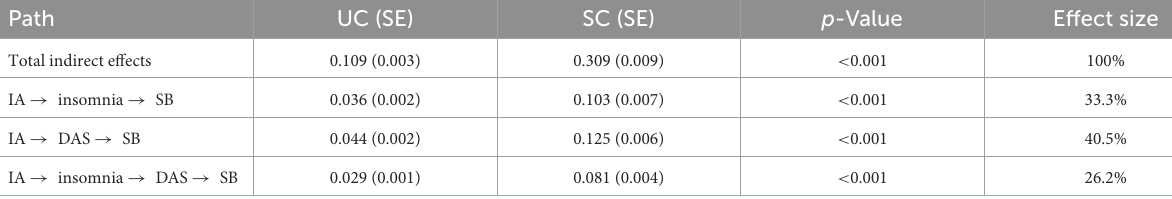
TABLE 5 Indirect effect of each mediate pathway from IA to suicidal behavior.